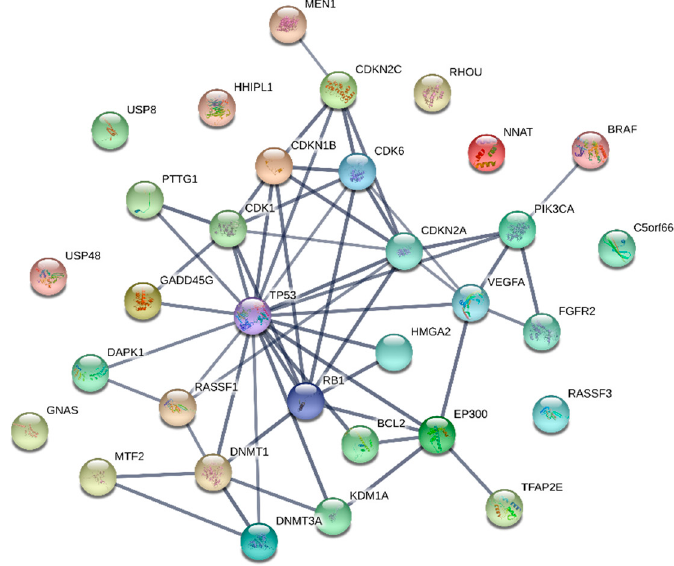
Figure 1. Interaction network of investigated marker molecules and their target proteins. Connected molecules may be less specific to the pituitary than separated ones.